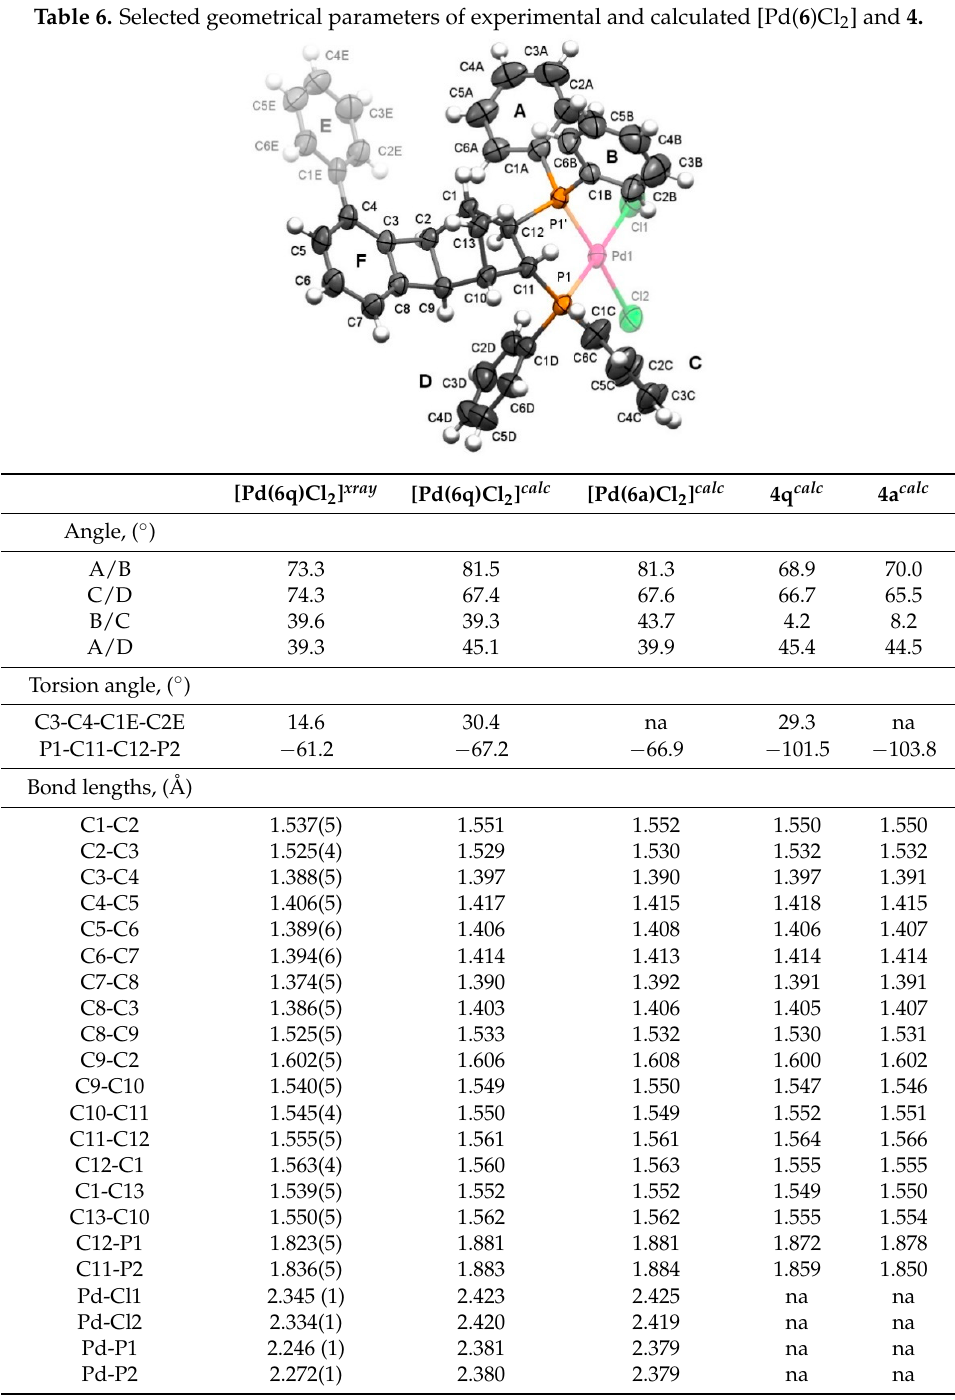
Molecules 2019 , 24 , x 12 of 22